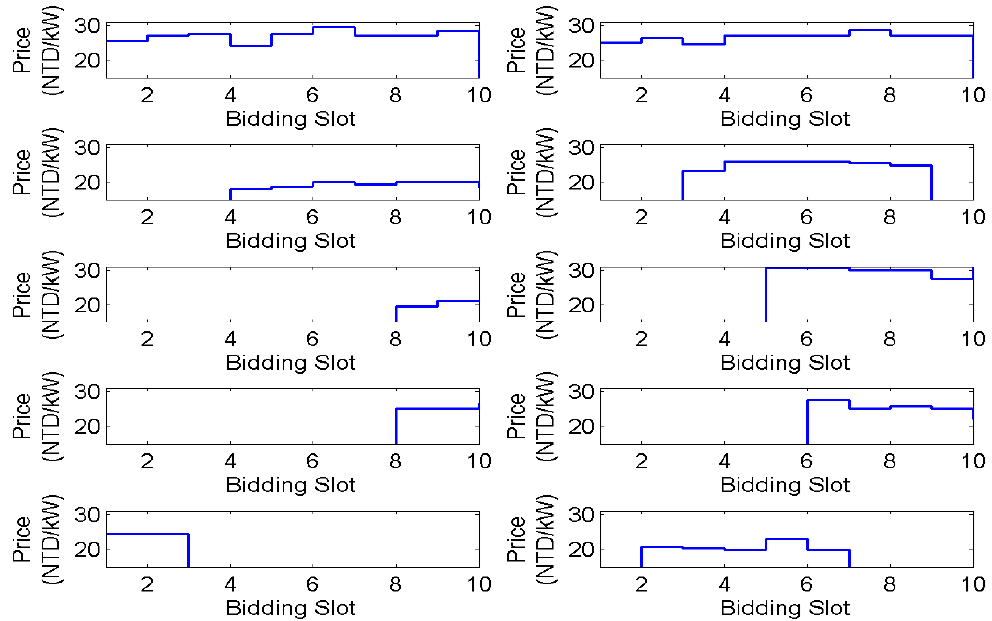
Figure 3. The bidding price per kWh offered by ten randomly selected customers at each bidding slot for case 2 of demand bidding with M = 10.